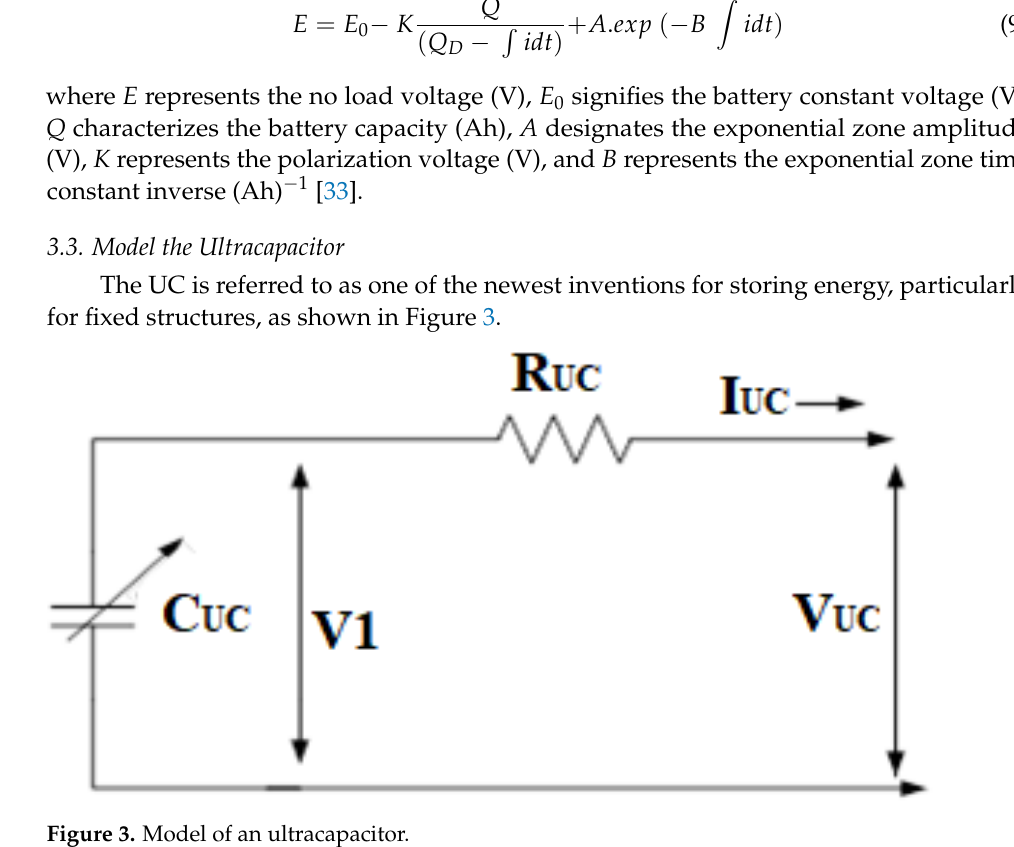
Figure 3. Model of an ultracapacitor.